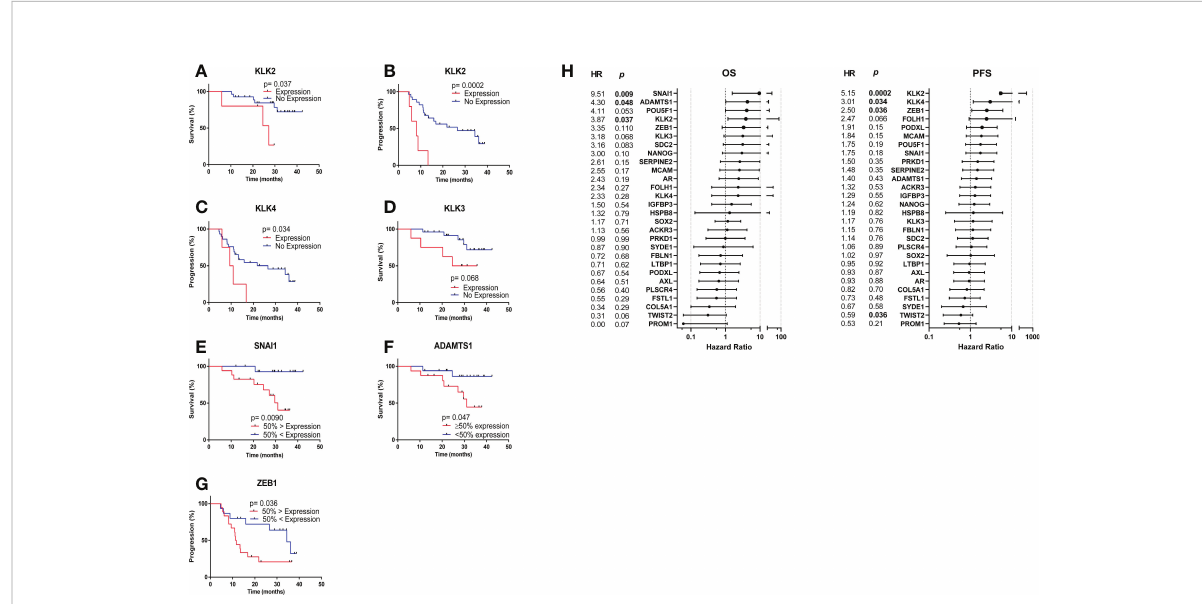
FIGURE 5 Kaplan Meier analysis based on CTC gene expression. (A) KLK2 expression was signi fi cantly associated with shorter median OS (27.17 vs. unde fi ned months, HR= 3.87, p= 0.037). (B) KLK2 expression was signi fi cantly associated with shorter median PFS (8.13 vs. 26.57 months, HR= 5.15, p= 0.0002). (C) KLK4 expression was signi fi cantly associated with shorter median PFS (10.17 vs. 26.57, HR= 3.01, p= 0.034). (D) KLK3 (PSA) expression had a trend towards signi fi cant association with shorter median OS (30.13 vs. unde fi ned months, HR= 3.18, p= 0.068). (E) Patients with 50% highest SNAI1 expression experienced signi fi cantly shorter median OS (31.07 vs. unde fi ned months, HR= 9.51, p= 0.0090). (F) Patients with 50% highest ADAMTS1 expression experienced signi fi cantly shorter median OS (31.07 vs unde fi ned months, HR= 4.30, p= 0.047). (G) Patients with the 50% highest ZEB1 expression experienced signi fi cantly shorter median PFS (11.50 vs. 24.40 months, HR= 2.5, p= 0.036). (H) Hazard ratios for each gene for OS and PFS. Unde fi ned months: The probability of survival exceeds 50% at the longest time